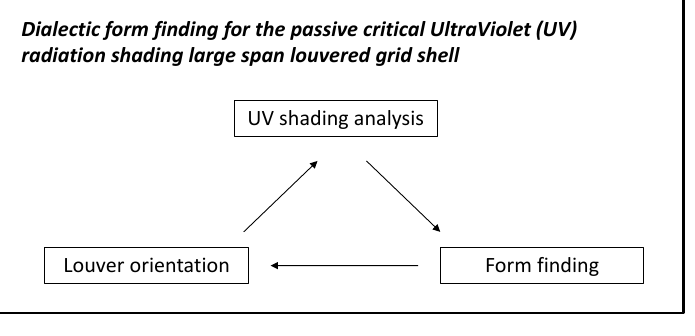
Figure 2. Illustration of the iterative integrated aspect of the dialectic form finding for the passive critical UV radiation shading large span louvered grid